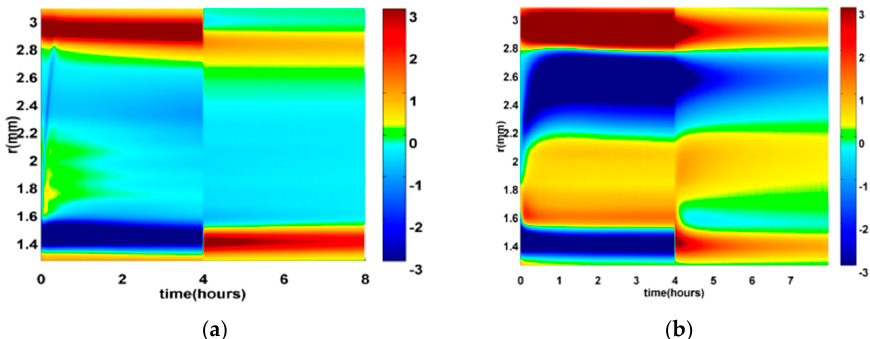
Figure 3. Space charge density patterns corresponding to field profiles shown in Figure 1. The color scale represents charge density in C/m 3 . ( a ) degassed sample; ( b ) partly degassed sample.